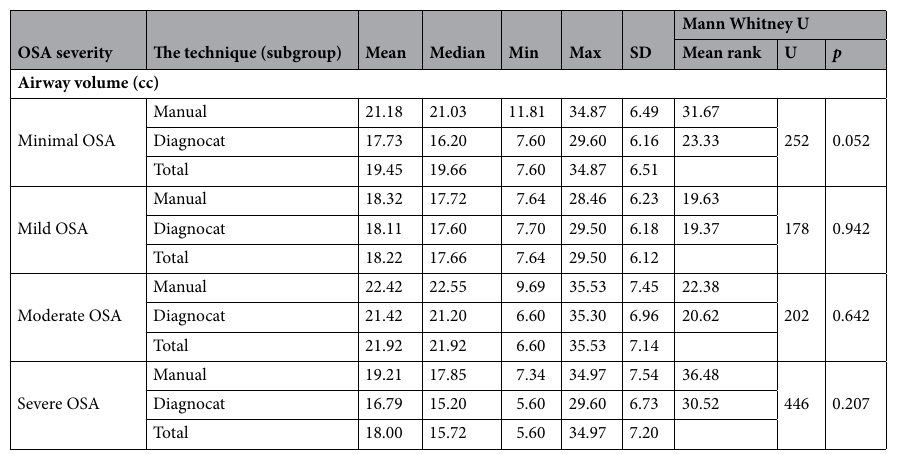
Table 1. Comparison of the airway volume measurements of Diagnocat and manual technique in patients with different OSA